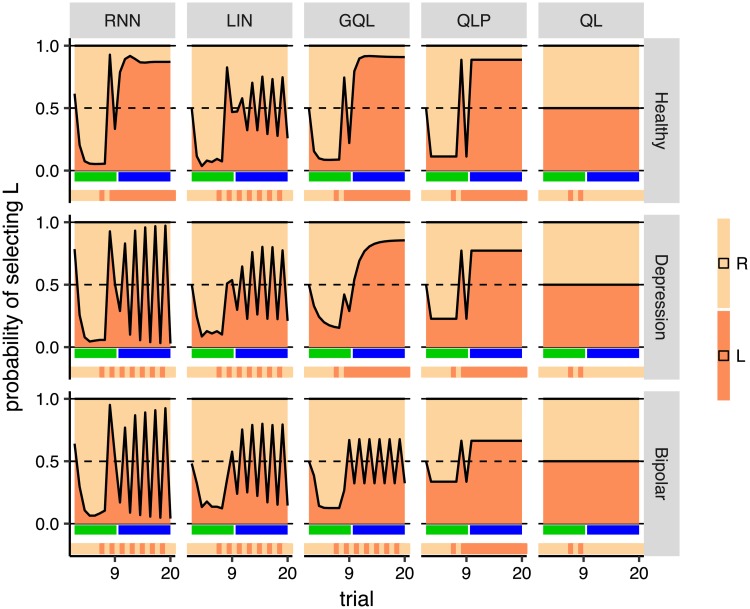
Mixed off-policy and on-policy simulations of the models.Each panel shows a simulation of 20 trials for which the first nine trials were off-policy and the subsequent trials were on-policy, during which the action with the highest probability was selected. Trials marked with green ribbons were off-policy (actions were fed to the model), whereas the trials marked with blue ribbons were on-policy (actions were selected by the model). The ribbon below each panel shows the actions that were fed to the model (for the first 9 trials), and the actions that were selected by the model (on the subsequent trials). During off-policy trials, the sequence of actions that was fed to the model was R, R, R, R, R, R, L, R, L. See the text for interpretation.